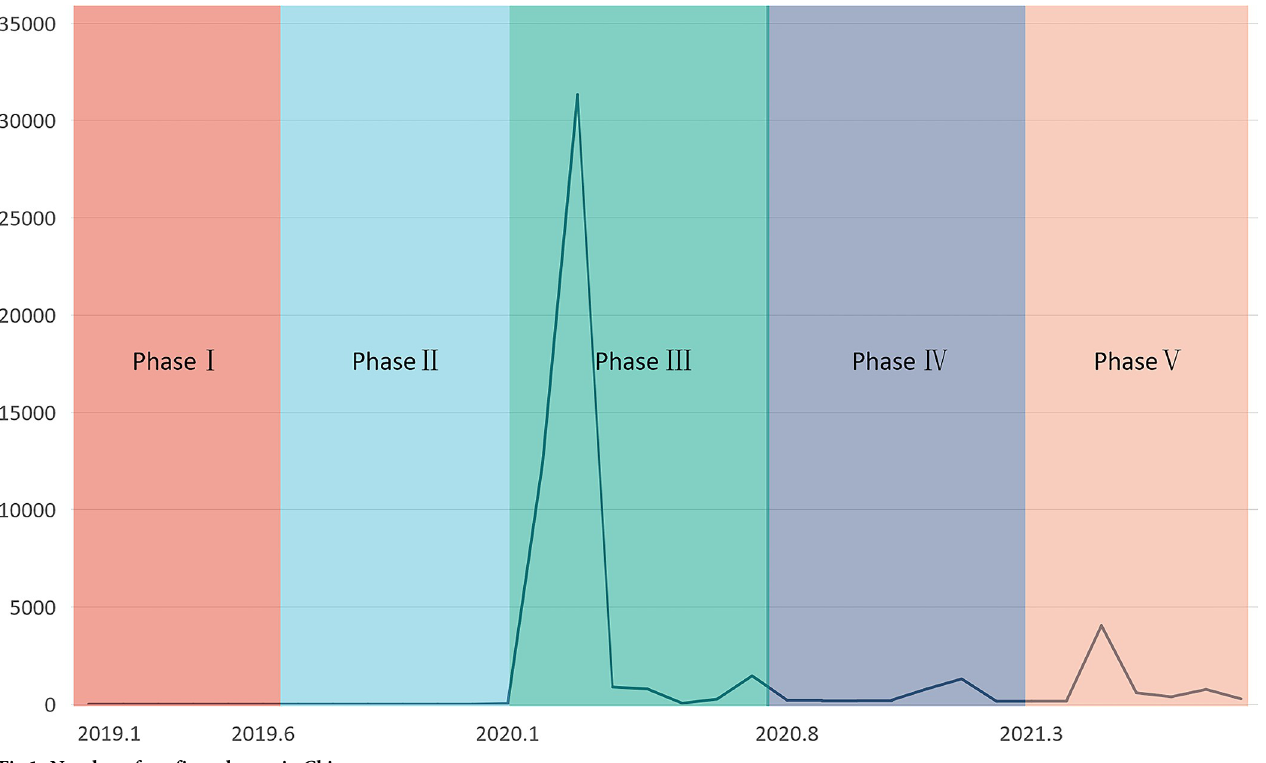
Fig 1. Number of confirmed cases in